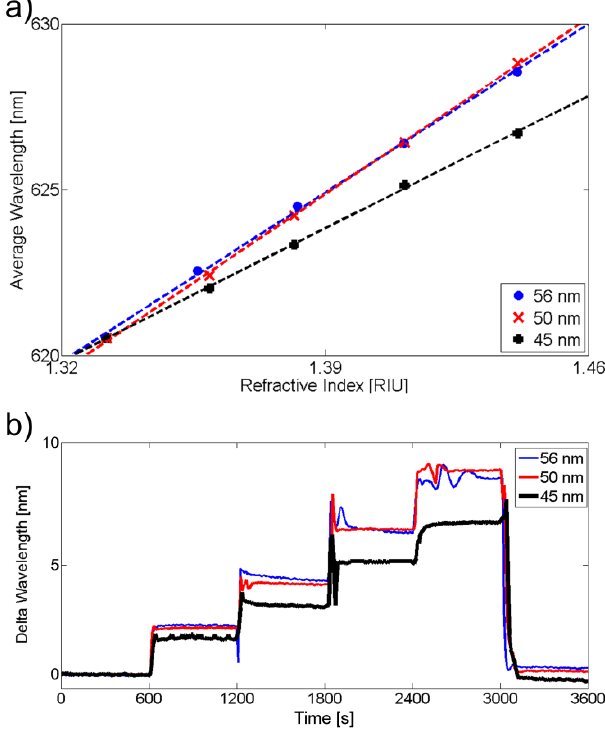
Figure 5. (a) The average peak resonance wavelength of three arrays of different nanowire widths on an evaporated Au sample as a function of the refractive index of the surrounding media. The slope corresponds to the bulk refractive index sensitivity, 𝑚 spectral position of the LSPR peak of an evaporated Au sample as a function of time for varying concentrations of glycerol with different refractive indices. The higher the refractive index of the surrounding medium, the higher the resonance wavelength. (The high pressures in the flow cell and/or air bubbles during medium exchanges could account for the strong fluctuations of the signal just after each new injection of glycerol, especially pronounced at a glycerol level of 80%).